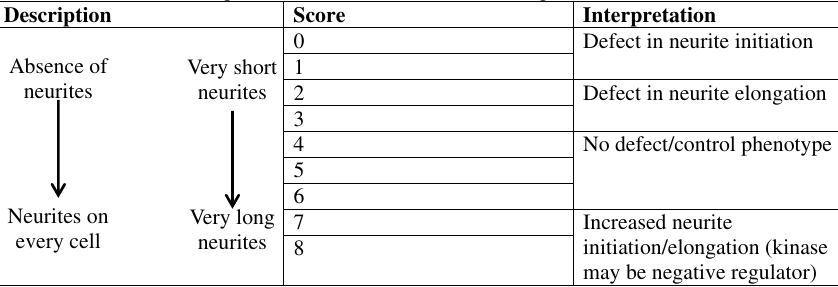
Table 1: Scale for scoring number of neurites and neurite length in N-2a cells noitaterpretnIerocSnoitpircseD